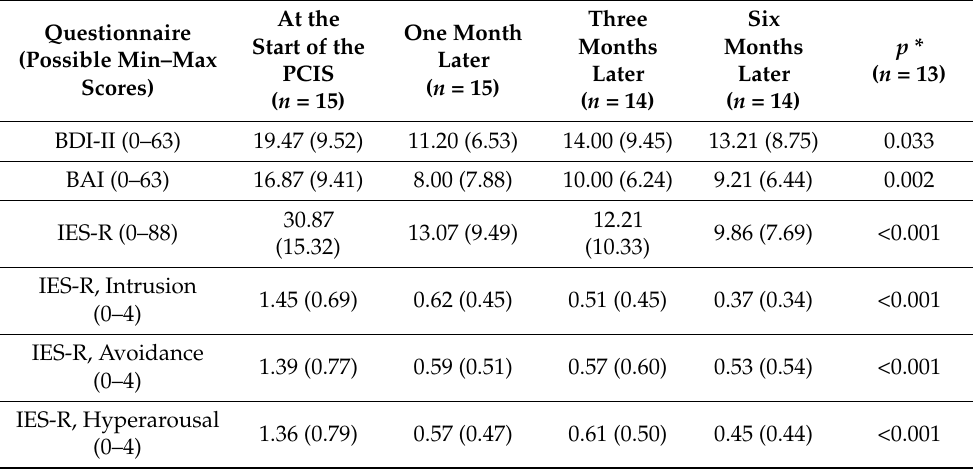
Table 1. Mean scores with standard deviation by